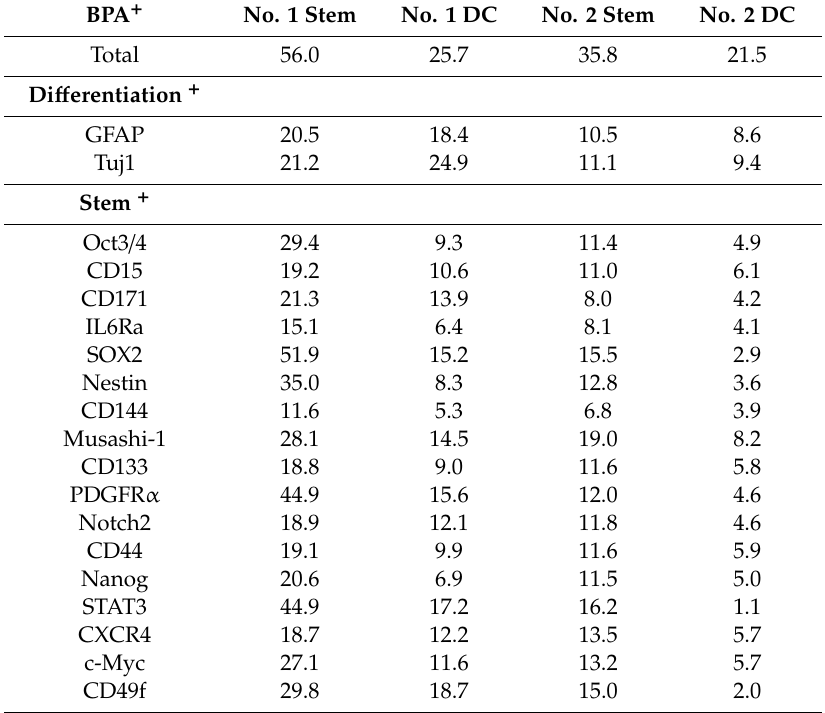
Table 1. Percentages of total p -boronophenylalanine (BPA + ) cells, BPA + / di ff erentiation marker + cells and BPA + / stem marker + cells among glioma stem-like cells (Stem) and di ff erentiated cells (DC) from no. 1 and no.